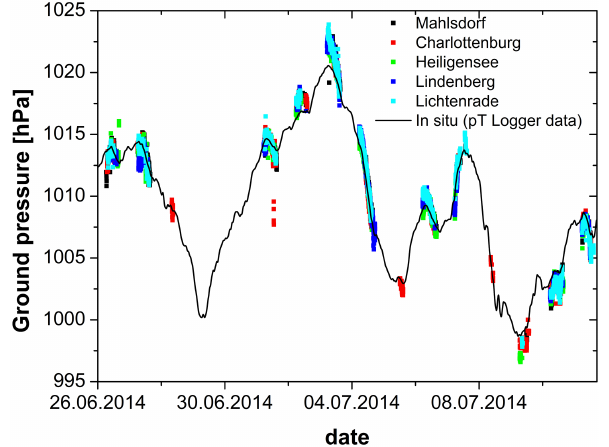
Figure 3. Time series of ground pressure according to the barom- eter measurements performed at each site (black line) and derived from the infrared spectra (dots). All pressure values were reduced to a common reference altitude of 30m. For the spectroscopic results, the dry-ground pressure has been derived from the 1.27µm oxy- gen band, and the contribution of water vapour to the total ground pressure has been taken into account. In order to achieve the best agreement with the barometer results, a calibration factor of 0.9713 has been applied to the spectroscopic results.